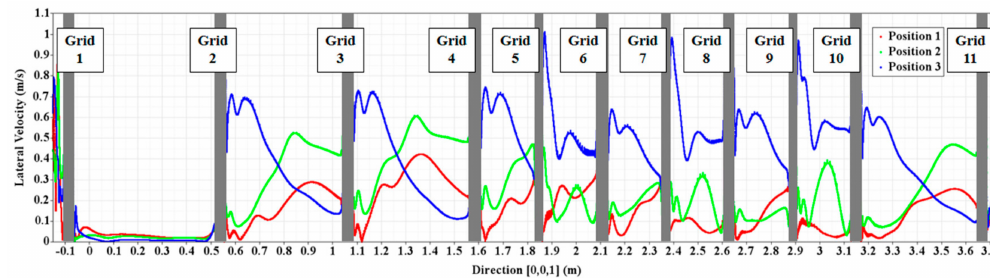
Figure 17. Change of the lateral velocity along the flow